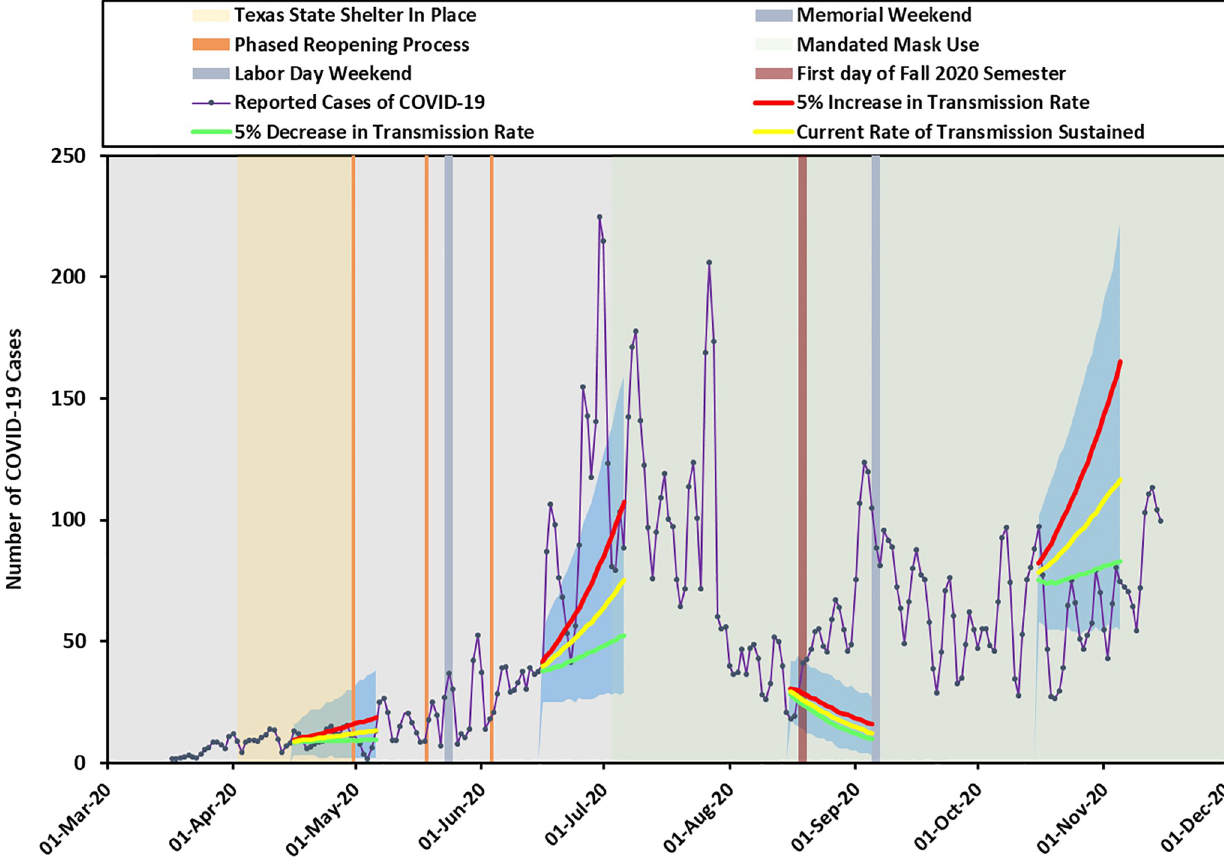
Fig 5. Brazos Valley predicted incidence cases using 12-day intervals. Three solid lines represent the predicted cases corresponding to current rate of transmission sustained, 5% increase in transmission rate, and 5% decrease in transmission rate. The shaded areas indicate prediction intervals.